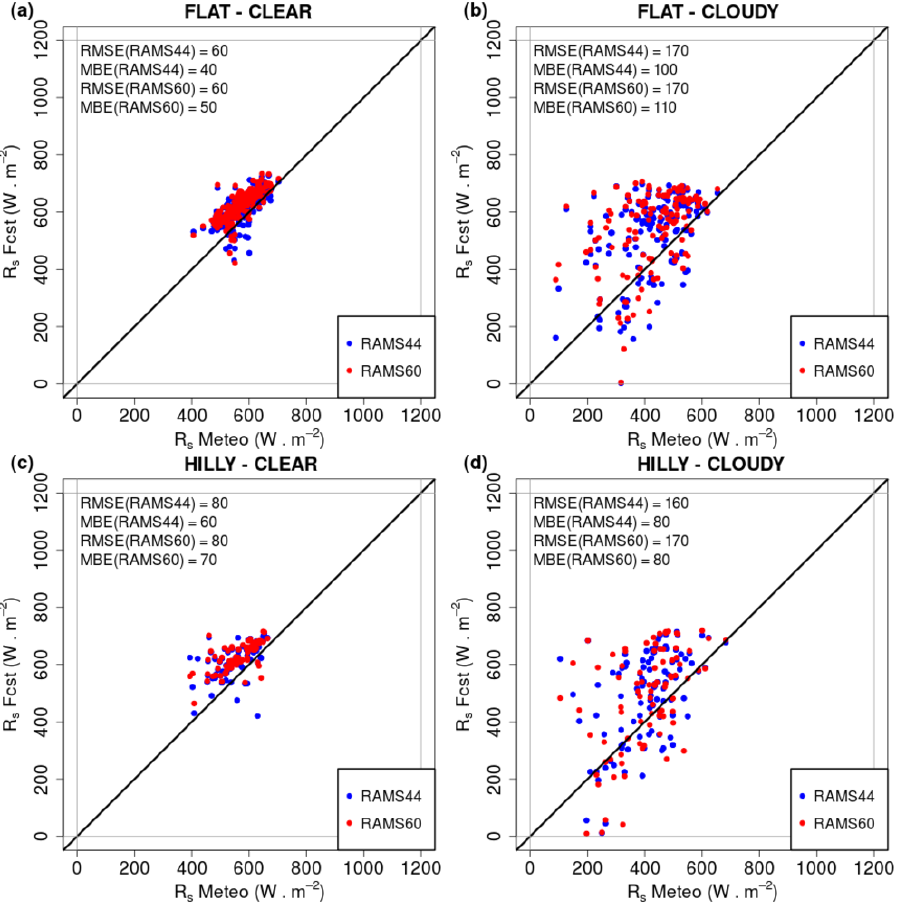
Figure 4. Daily Regional Atmospheric Modeling System (RAMS) (R s Fcst; W·m − 2 ) solar radiation vs. daily solar radiation measured at the surface weather stations (R s Meteo; W·m − 2 ) during the summer 2011, segmented based on terrain classes (flat and hilly) and atmospheric condition (clear and cloudy sky): flat-clear ( a ); flat-cloudy ( b ); hilly-clear ( c ) and hilly-cloudy ( d ). Statistical scores values (RMSE and MBE) presented in W·m − 2 .